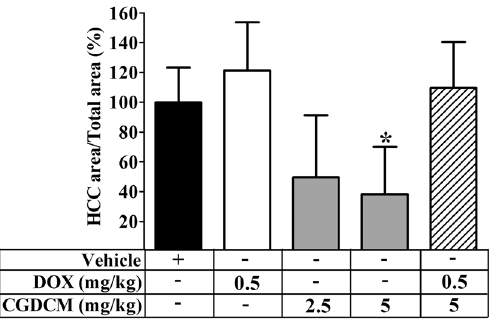
Figure 9. Quantitative examination of the prevalence of HCC. Liver H&E sections at the end of the treatments (week 16) were scanned by Zeiss Axio Scan Z1 (Zeiss, Germany) and measured the area by the METAVIR scoring system (ZEN blue 2.3). Histograms show the relative HCC area (%). The vehicle group was treated with 0.8% DMSO. DEN administration was performed for 8 weeks, and the treatments were performed for 4 weeks from week 12, which included DOX, CGDCM-L, CGDCM-H, and the combination of DOX with CGDCM-H. The data were analyzed using one-way ANOVA with Tukey’s HSD test and reported as the mean ± SD (n = 7), *p < 0.05 compared to the vehicle at week 0. CGDCM , C. gigantea dichloromethane extract; CGDCM-L, CGDCM low dose; CGDCM-H, CGDCM high dose; DOX,